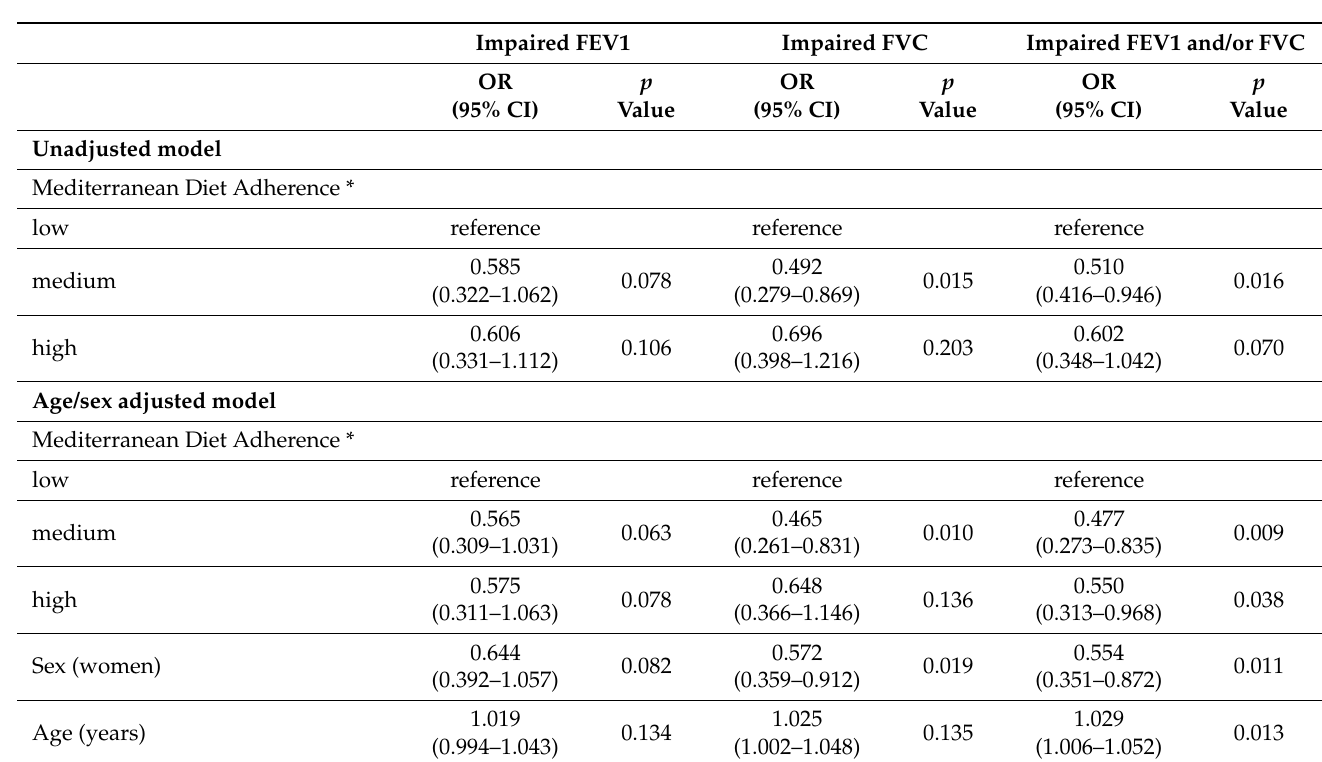
Table 3. Relationship between Mediterranean Diet Adherence Group and impaired